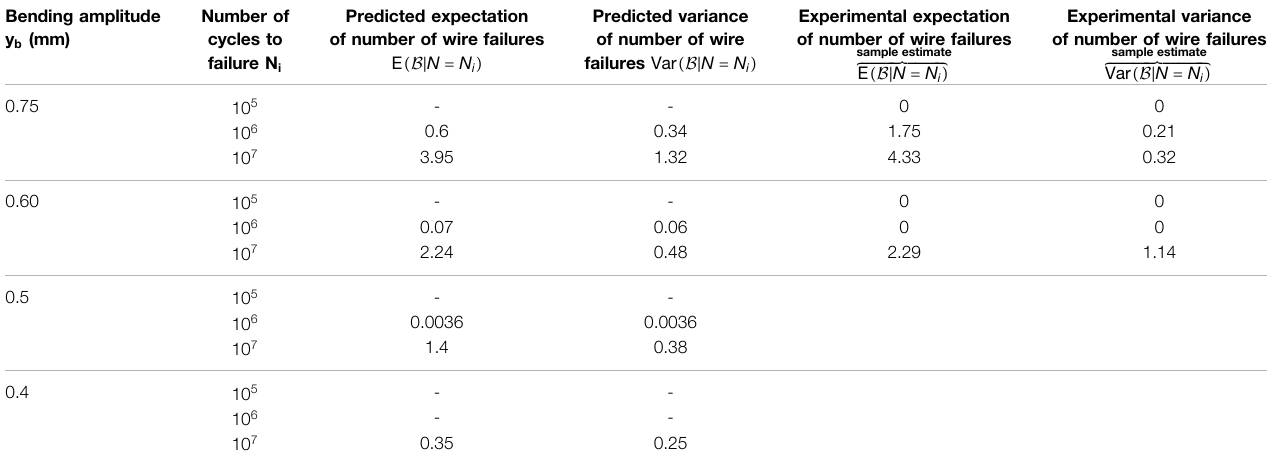
TABLE 3 | Comparison of predicted number of wire failures against experimental observation. Bending amplitude y b